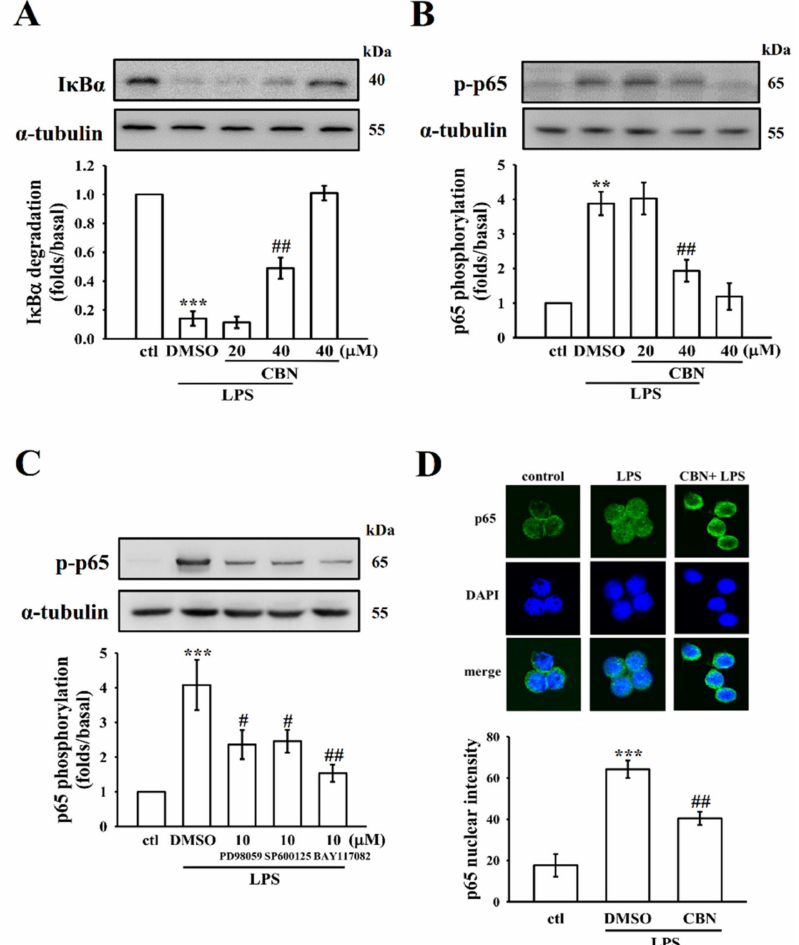
Figure 3. Effects of CBN on LPS-induced NF- κ B signaling pathway in RAW cells. RAW cells were treated with CBN (20 and 40 µ M) for 20 min with or without LPS (1 µ g/mL) for 30 min. Immunoblotting assay was performed to detect ( A ) I κ B α degradation and ( B ) p65 phosphorylation. ( C ) Effect of the BAY117082, PD98059, or SP600125 on p65 phosphorylation in LPS-induced RAW cells. ( D ) CBN reversed LPS-induced NF- κ B p65 nuclear translocation. Data were graphed by pooling multiple images, with each individual data point corresponding to the mean fluorescence intensity of each individual cell nucleus. ** p < 0.01 and *** p < 0.001, LPS vs. control cells; # p < 0.05, and ## p < 0.01, LPS vs. CBN-treated cells ( n =